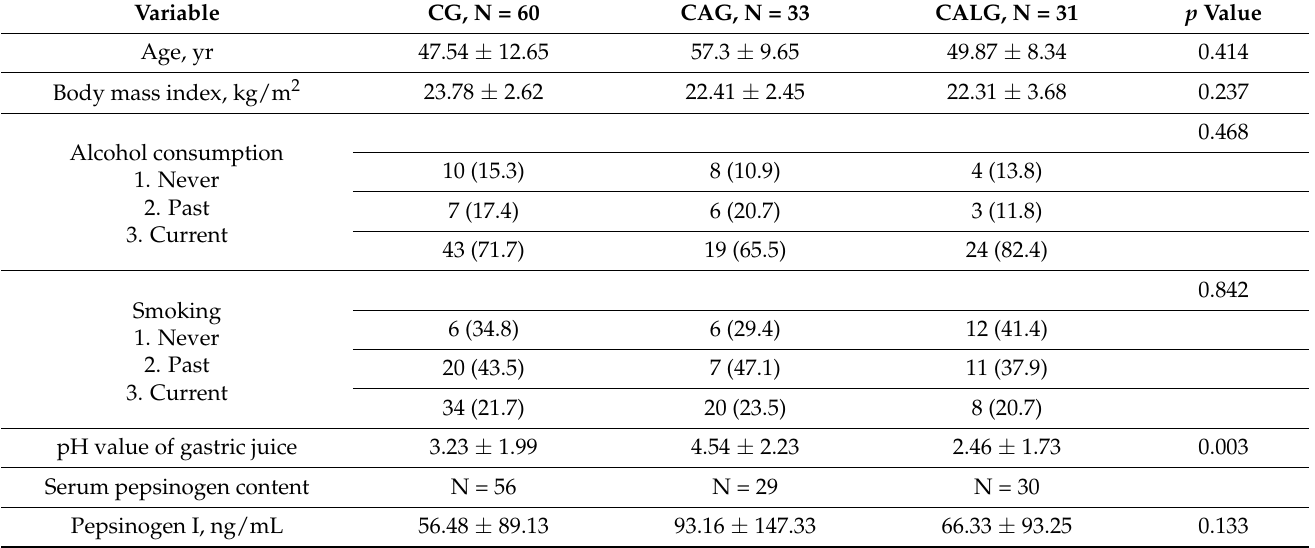
Table 1. Baseline characteristics of 124 subjects with various types of gastritis infected with Helicobac- ter pylori